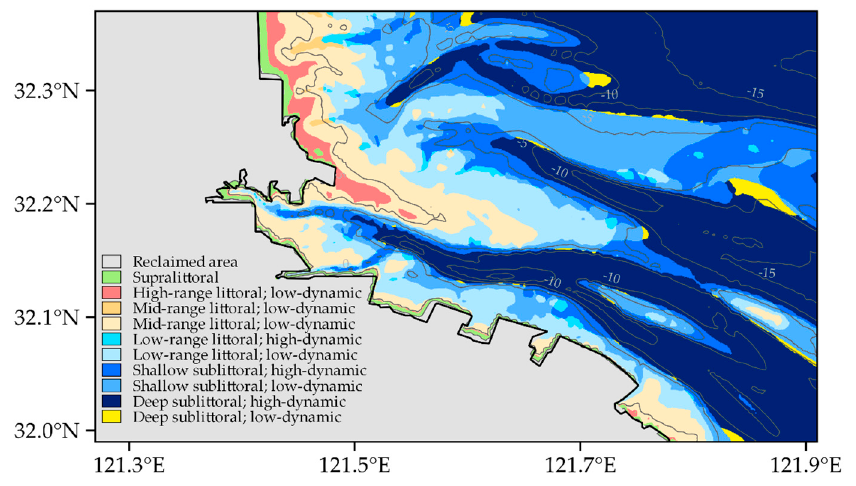
Figure 7. Ecotope map of Tongzhou Bay corresponding to 2012, adapted from Muller et al. [28].